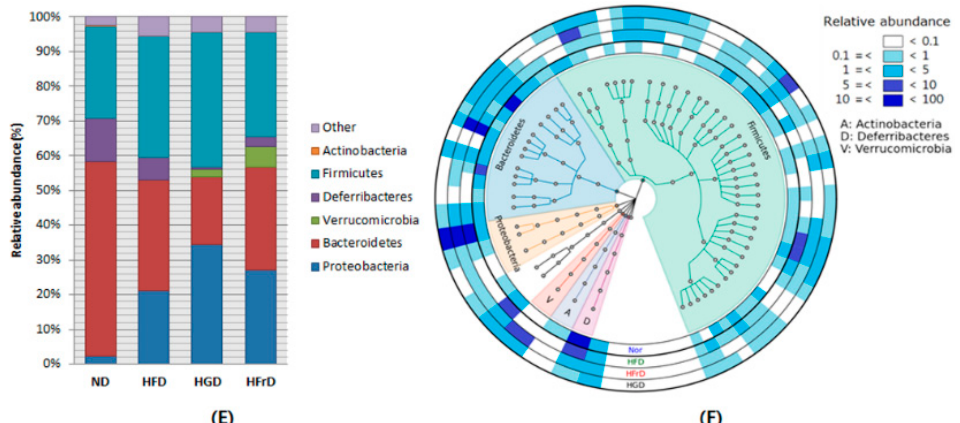
Figure 2. Analysis of the gut microbial community by 16S rRNA pyrosequencing from feces of HFD, HGD and HFrD groups. ( A ) operational taxonomic units levels; ( B ) Shannon’s diversity indices; ( C ) principal coordinate analysis of unweighted UniFrac analysis; ( D ) sample clustering results based on the unweighted UniFrac analysis; ( E ) relative abundances plot of bacterial phyla; ( F ) relative abundance cladogram of bacterial taxa. Data are presented as the mean ± SEM for 3 cages per group (** p < 0.01, and *** p < 0.001 vs. ND).